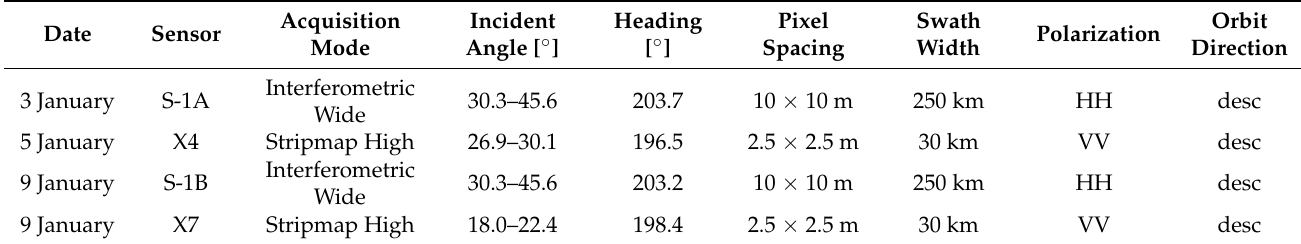
Table 1. Specification of the